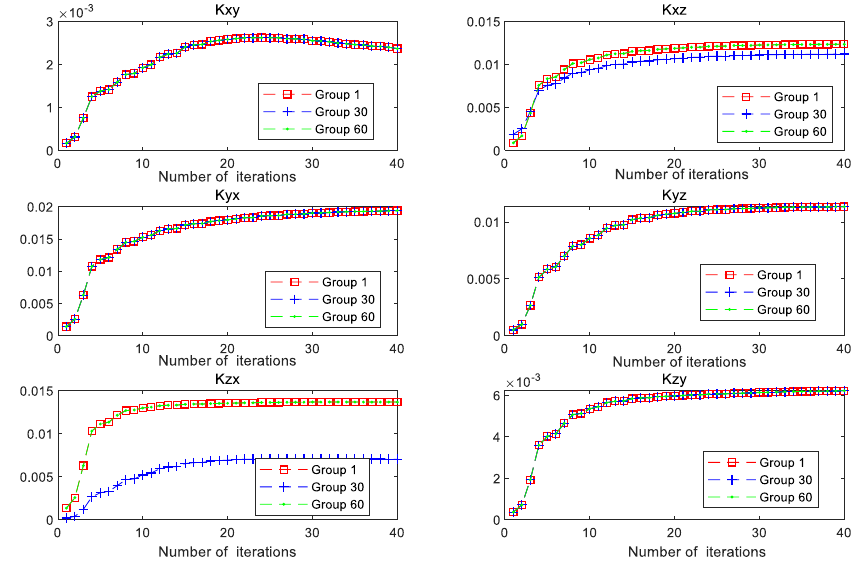
Figure 1. Gyroscope installation − error estimation results.